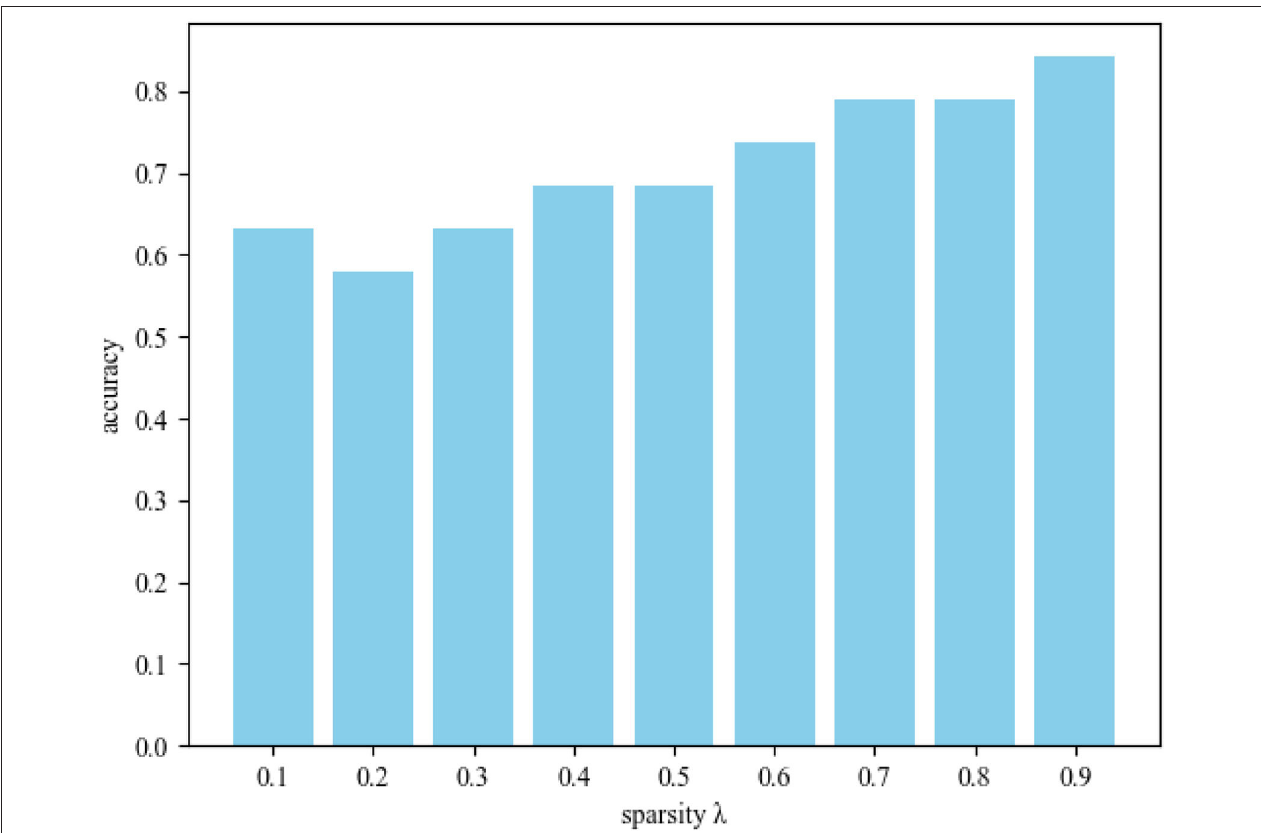
FIGURE 5 | Classification accuracy of different sparsity λ .